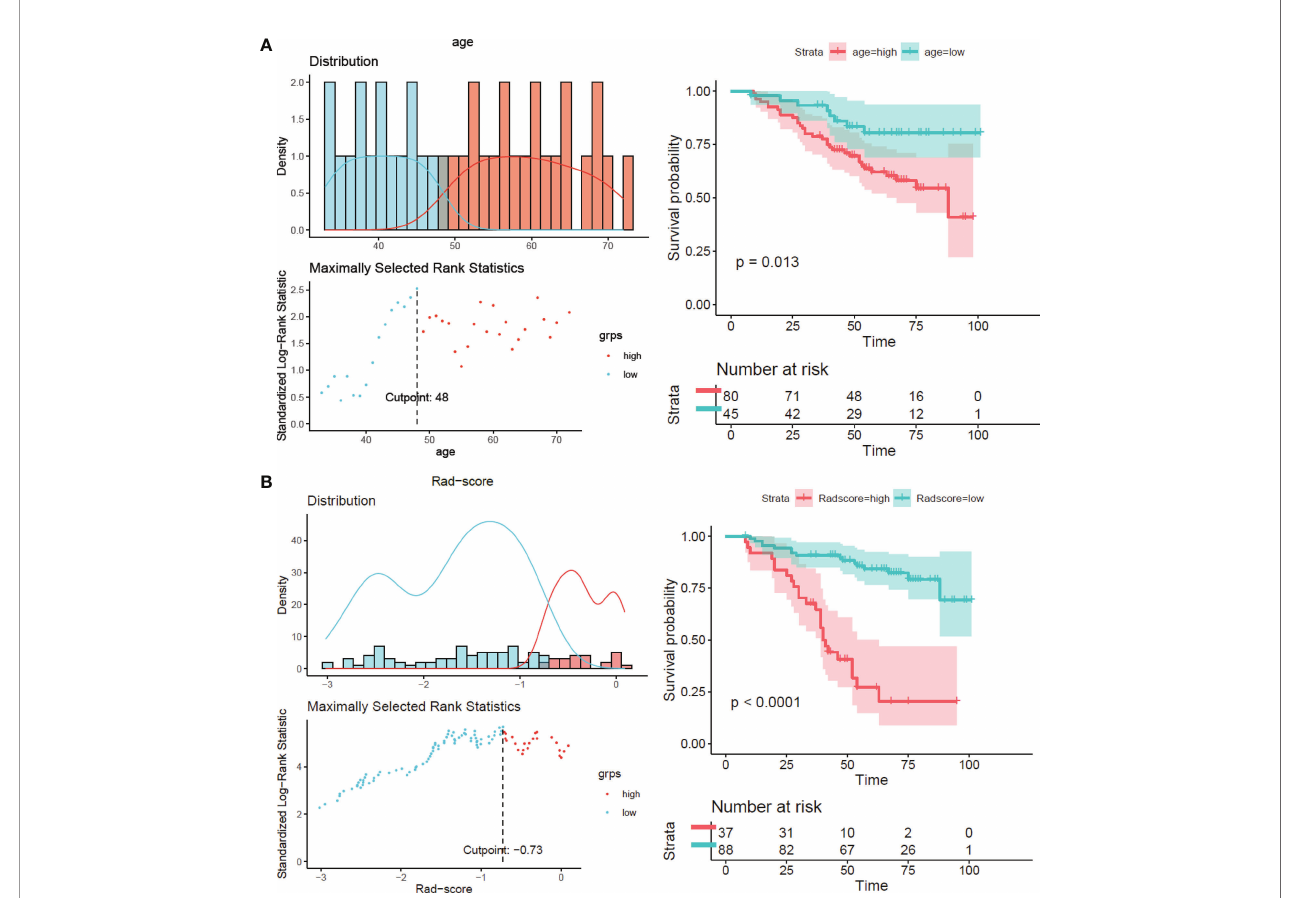
FIGURE 2 | Surv_cutpoint function and survival analysis of PFS in the training set. (A) RFs-weighted sum. (B)